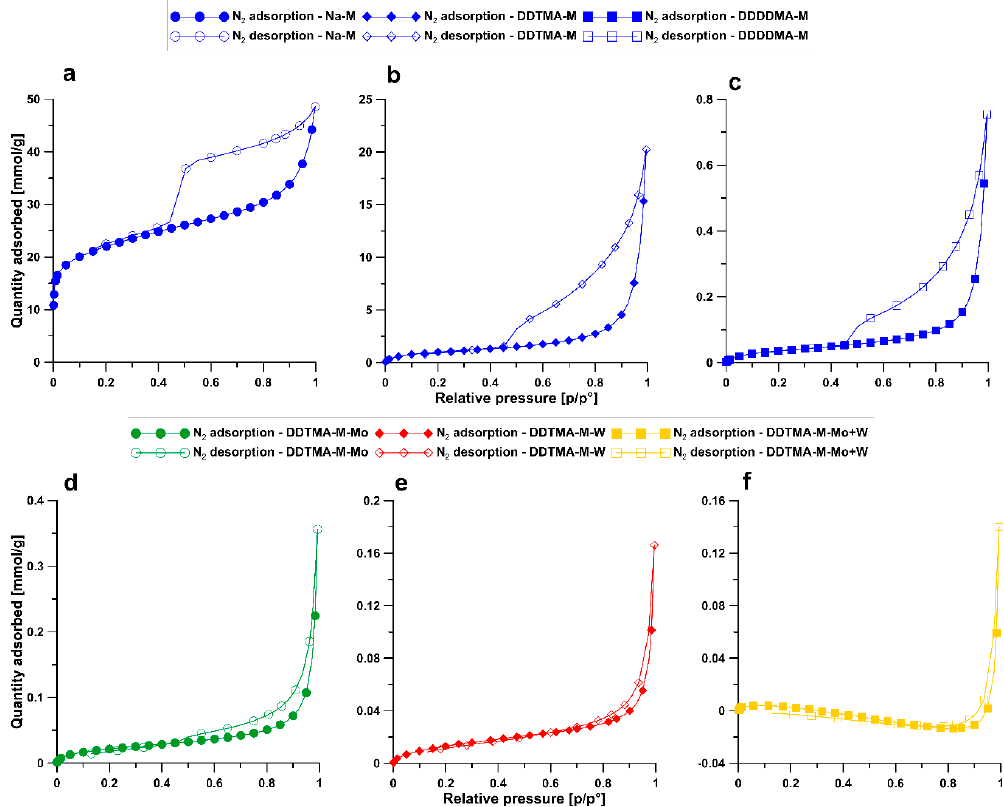
Figure 3. Nitrogen adsorption/desorption graph of samples: ( a ) Na-M, ( b ) DDTMA-M, ( c ) DDDDMA-M, ( d ) DDTMA-M-Mo, ( e ) DDTMA-M-W, ( f ) DDTMA-M-MoW.